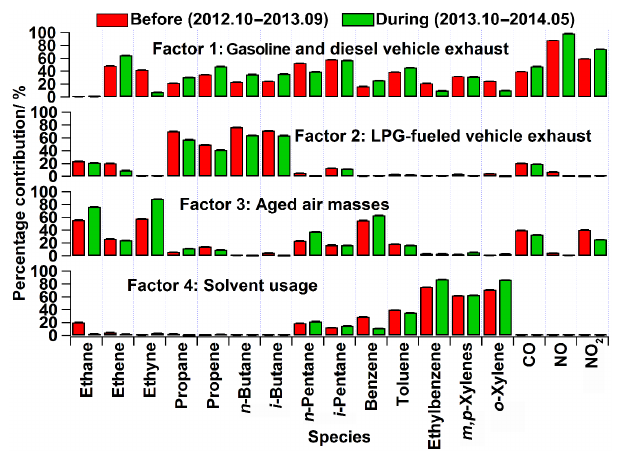
Figure 6. Source profiles resolved by PMF before (red bar) and during (green bar) the program. The standard errors are estimated with the bootstrap method in the model.